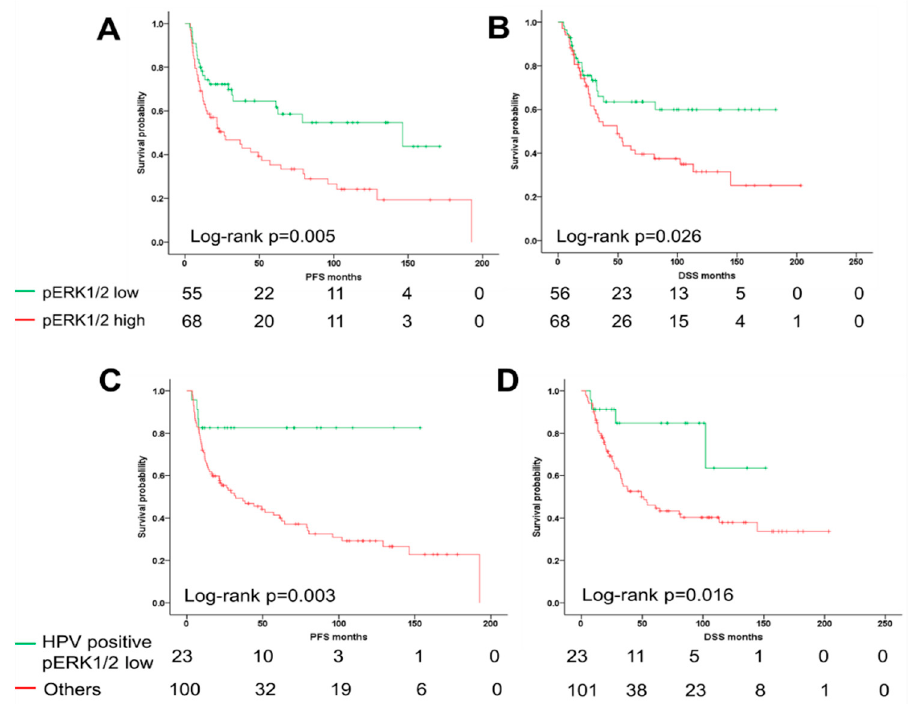
Figure 2. Correlation between pERK1/2 expression and survival of oropharyngeal squamous cell carcinoma (OPSCC) patients. The differences in progression-free ( A ) and disease-specific survival ( B ) between pERK1/2 staining patterns were plotted by a univariate Kaplan–Meier analysis and log-rank test. Human papillomavirus (HPV)-related OPSCC with low pERK1/2 expression show more favorable progression-free ( C ) and disease-specific survival ( D ). The number of survivors after a certain time interval (given in months) is displayed.